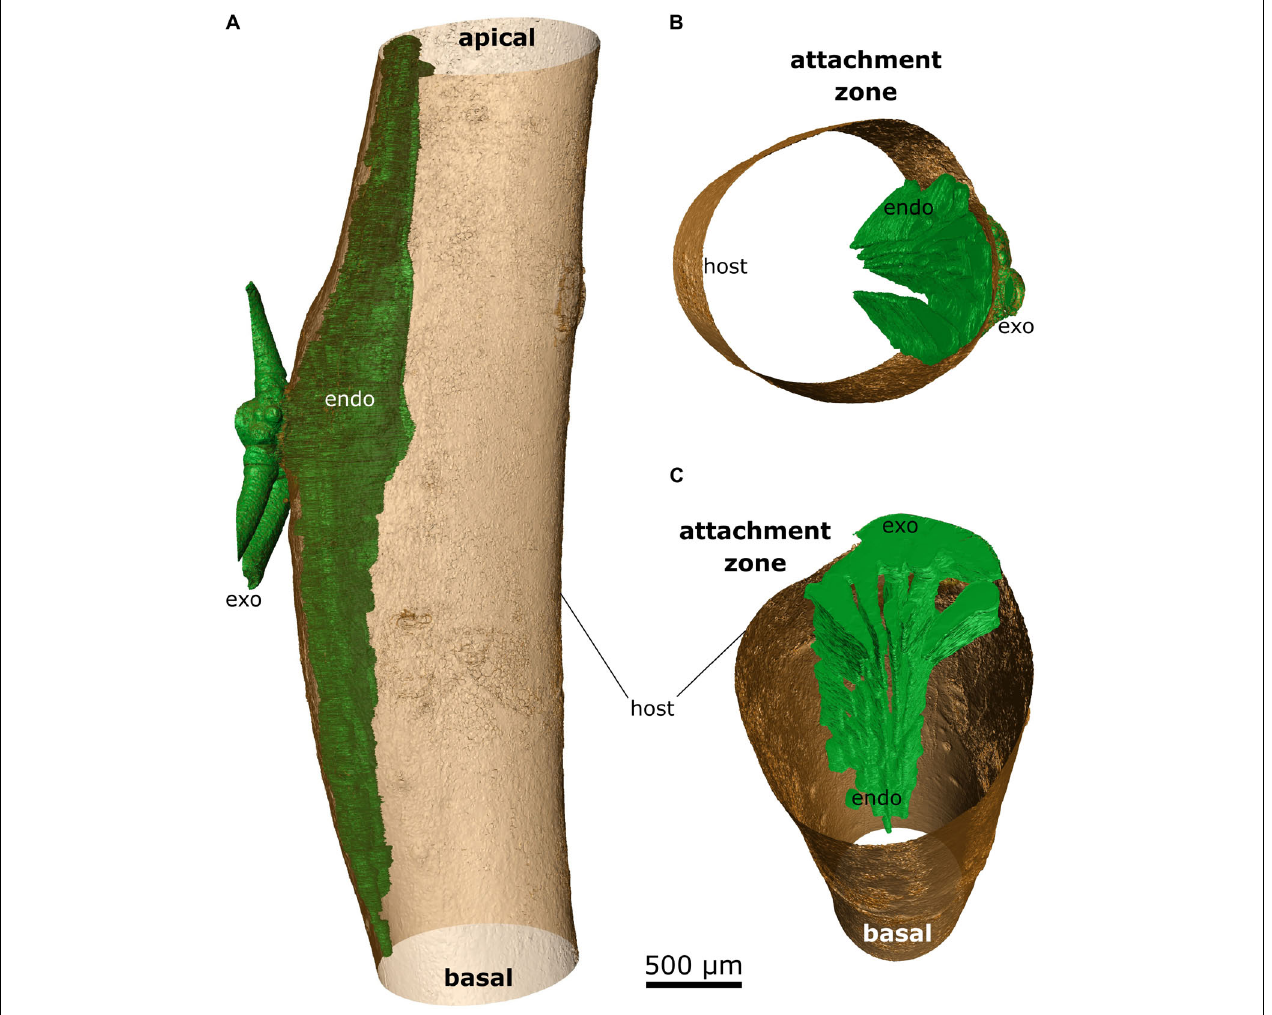
FIGURE 5 | False-color representation of segmented microCT data of the 4-year-old mistletoe. The mistletoe, consisting of endophyte (endo) and exophyte (exo, trimmed to fit the size of the scan volume), is colored green; the outer hull of the host branch is colored brown. (A) Overview of the mistletoe-host connection with the sinkers running basally and acropetally through the host branch. Detailed views of (B) the attachment site and (C) the sinkers running basipetally from the attachment site (the host branch is depicted as being